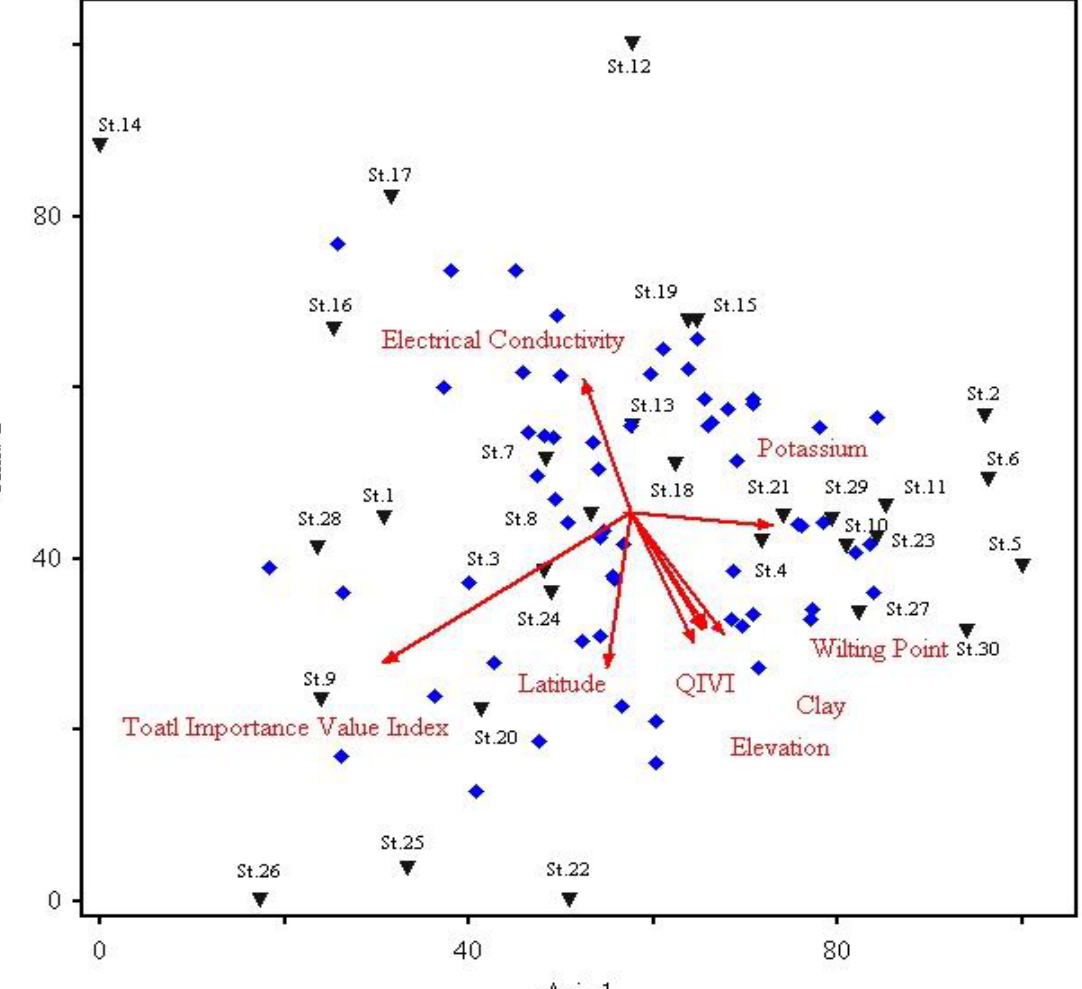
Figure 5. RDA ordination of physiographic and edaphic variables concerning stands and the understory vegetation. Note: Blue square represent the species point in the ordination biplot; St (Stand number). Table 6. Results of the RDA showed correlation coefficients between the physiographic and edaphic variables and the RDA axes and biplot scores of each variable on all the three axes.